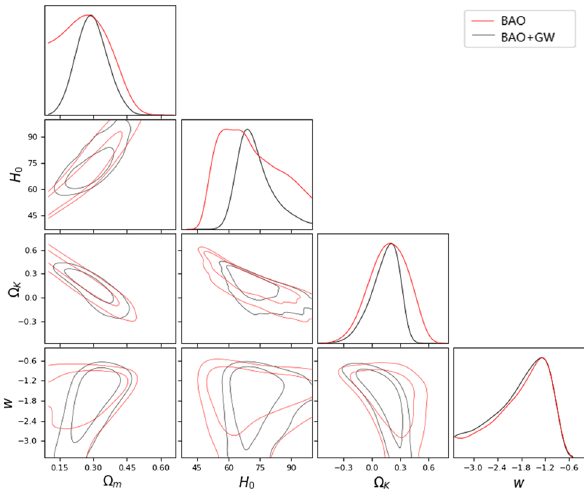
data. For three other parameters, the constraints also become tighter after adding the GW170817 data. Therefore, the GW measurement, combining with the BAO distance measures, can significantly improve the constraints on cosmological parameters in the Ω k w CDM model. In addition, the value of w is well consistent with Ω k is well consistent with 0, and −